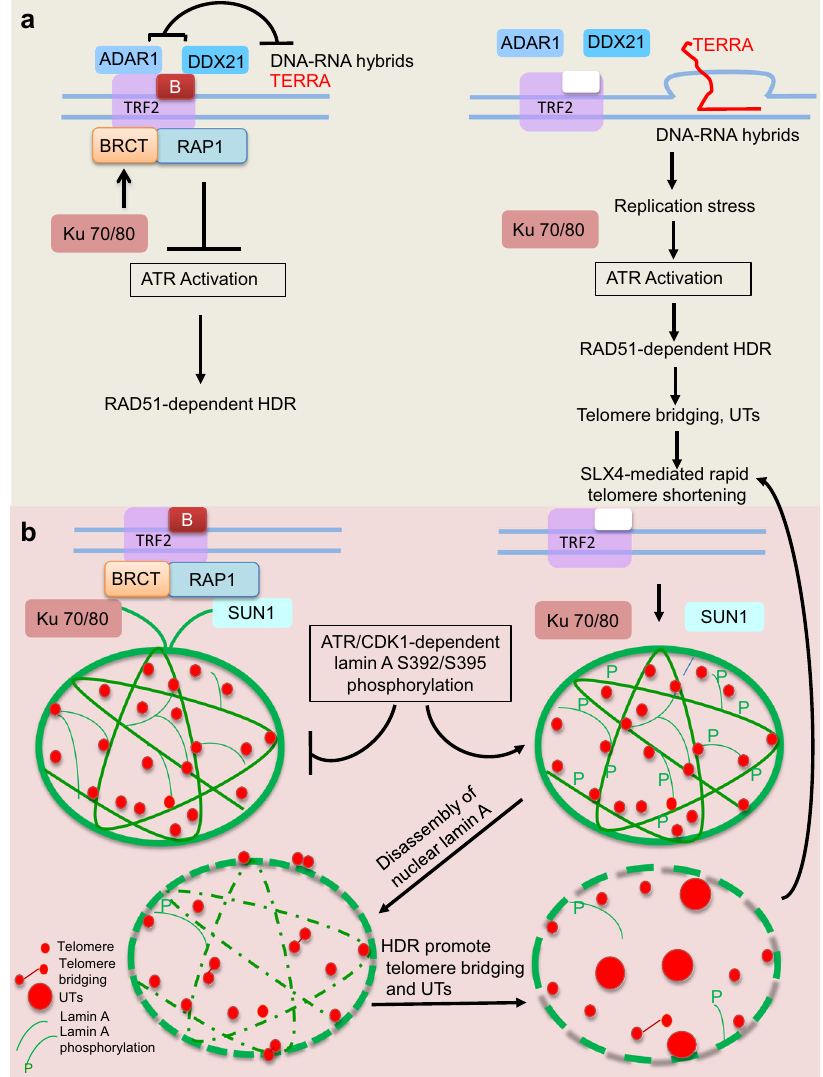
Fig.8|Speculativeschematicdiagramillustratingtheformationofultrabright telomeres in the absence of RAP1 and TRF2 B . a In WT cells, TRF2 B and RAP1 cooperate to protect chromosome ends from inappropriate activation of ATR- dependent HDR. TRF2 B recruits DDX21 and ADAR1p110 to telomeres to resolve DNA-RNAhybrids, preventing the formation of telomeric R-loops, TERRAand UTs. IntheabsenceofRAP1andTRF2 B ,stalledreplicationforksleadtoactivationofATR- CHK1, accumulation of telomeric R-loops and TERRA, promoting UT formation. Unresolvedtelomererecombinationintermediatesbecomesubstratesforcleavage